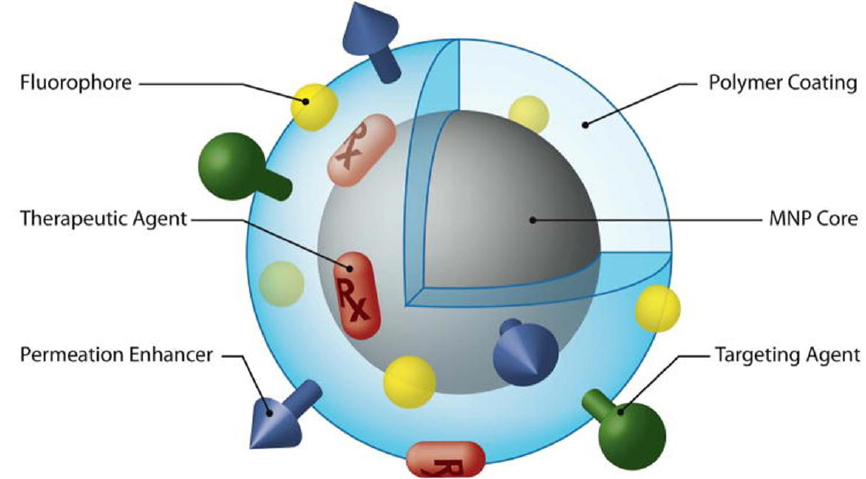
Figure 9. Magnetic nanoparticle (MNP) possessing various ligands to enable multifunctionality from a single nanoparticle platform. Reproduced from [92] with permission of